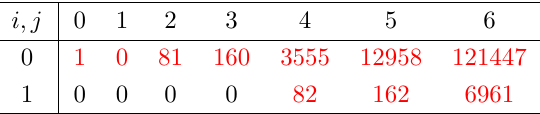
Table 22 . Coe(cid:14)cients c E 6